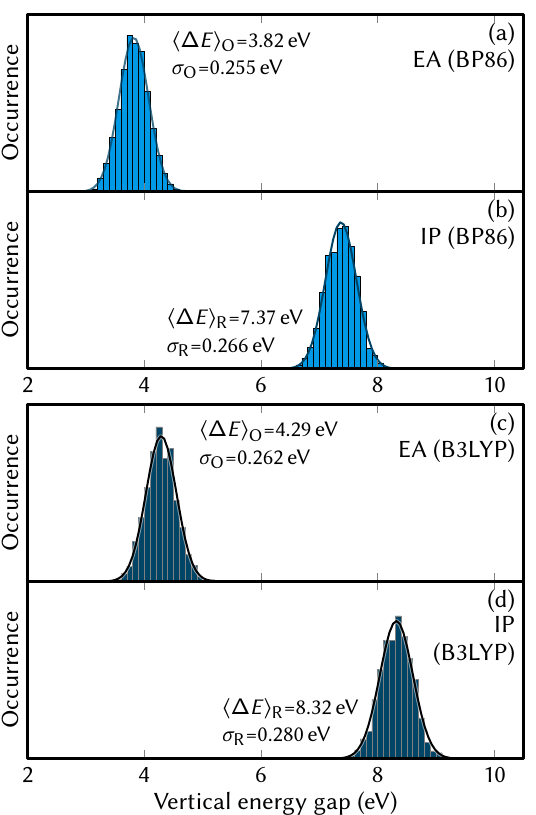
Figure 4. Distribution of vertical energy gaps from the trajectory snapshots at the BP86/def2-SVP level of theory. Panel ( a ) shows the gaps from the oxidized species (electron affinities), ( b ) shows the gaps from the reduced species (ionization energies). Panels ( c , d ) show the same data, but obtained at the B3LYP/def2-SVP level of